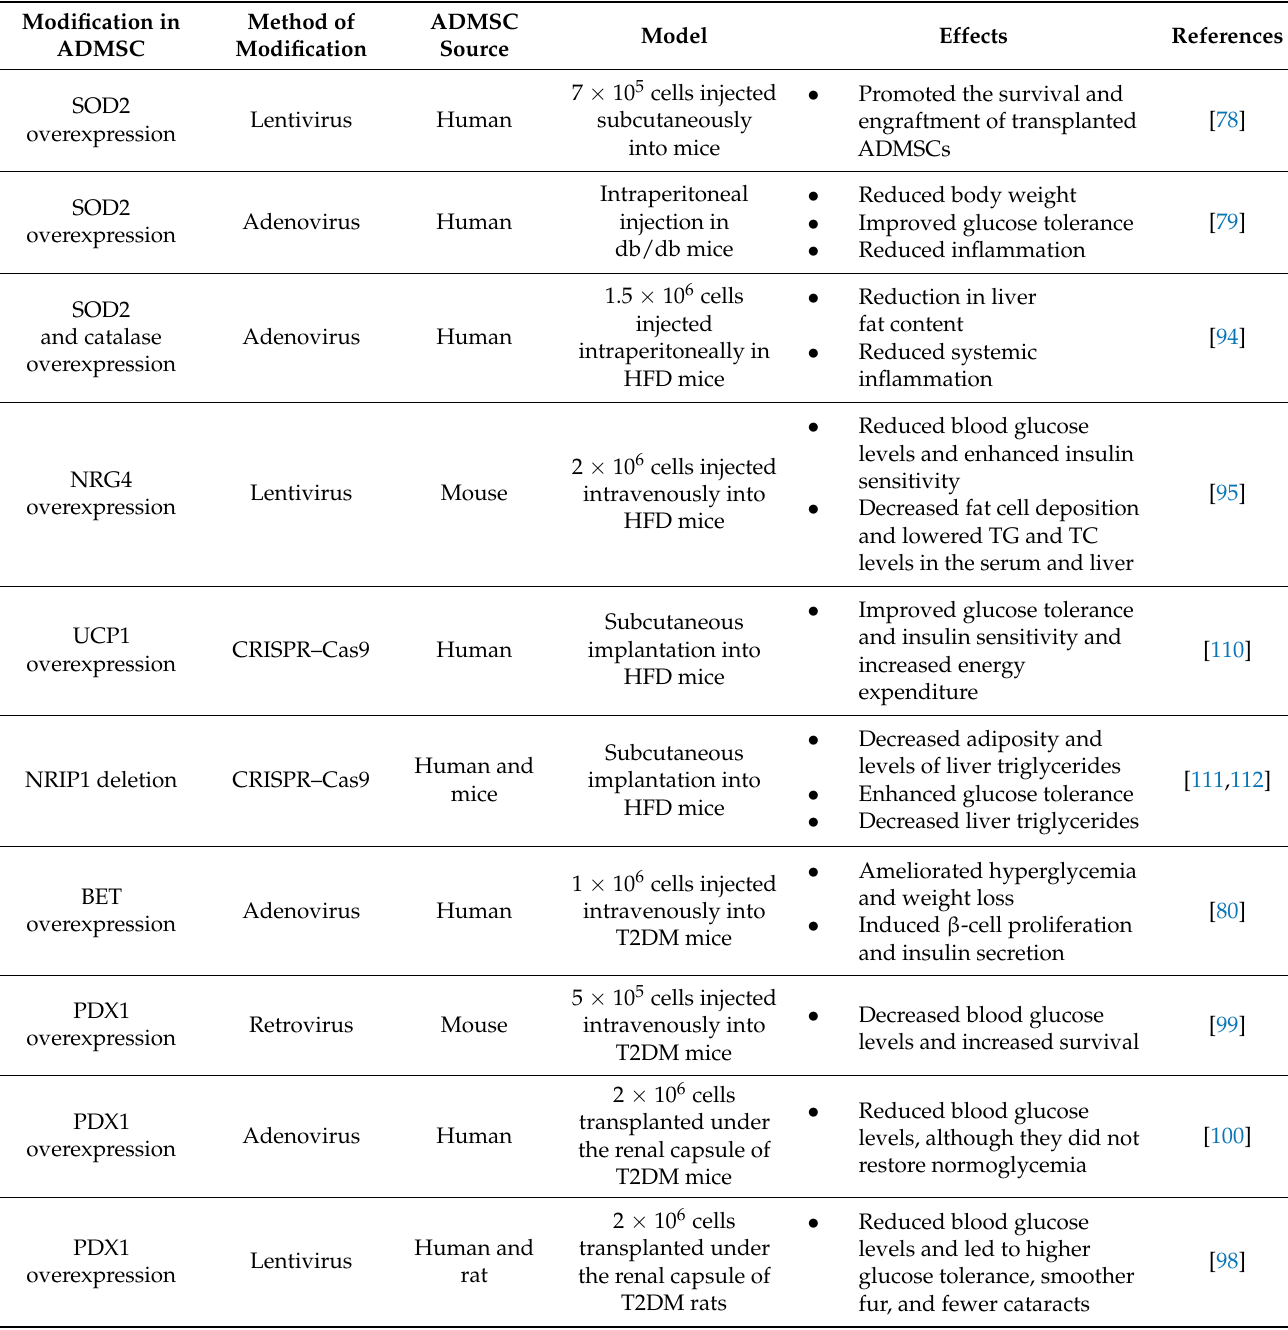
Table 2. Relevant genetic modifications of ADMSCs to increase their therapeutic